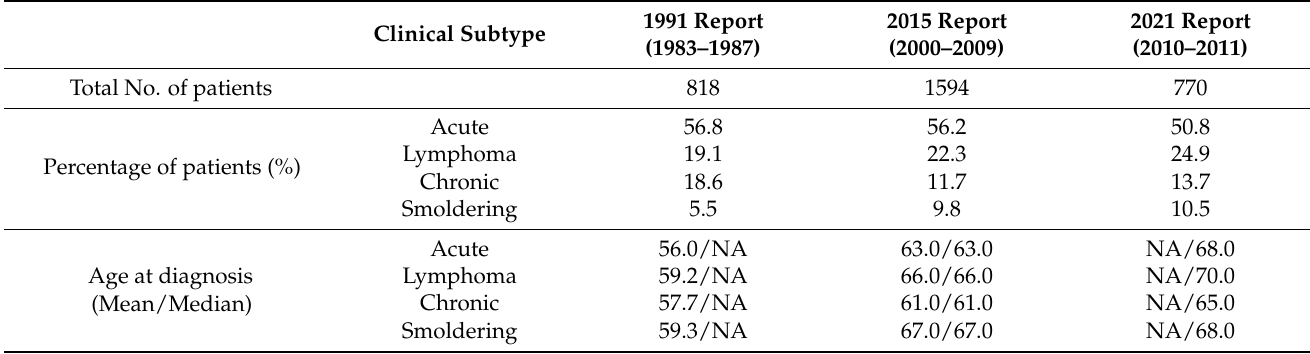
Table 1. The distribution, age at diagnosis, and prognosis of ATL by clinical